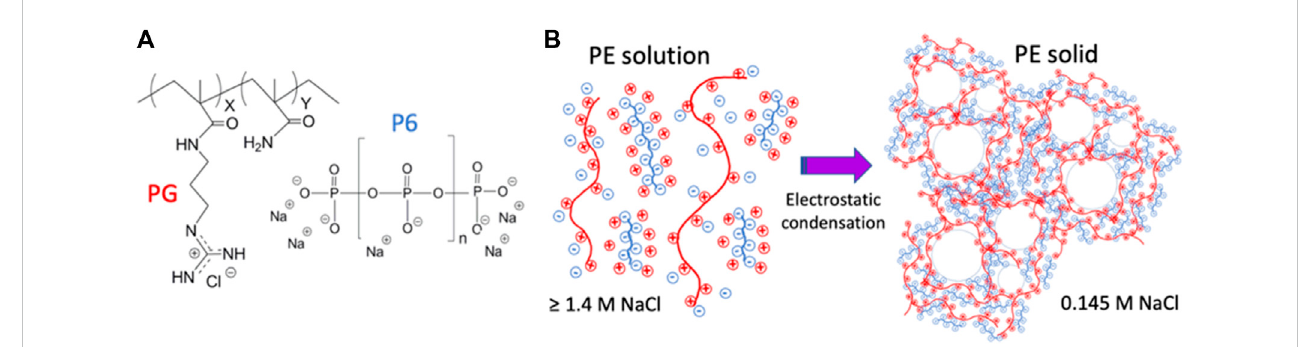
FIGURE 1 (A) ) Polyelectrolyte components of GPX. PG: chloride salt of N-(3-guanidinopropyl) methacryamide-co-methacrylamide. P6: sodium salt of hexametaphosphate. (B) ) GPX liquid-to-solid transition mechanism. In solution, counter-ion shielding prevents macro-ion association. In low ionic strength environments, counter-ion diffusion leads to macroion association and solidi fi cation.